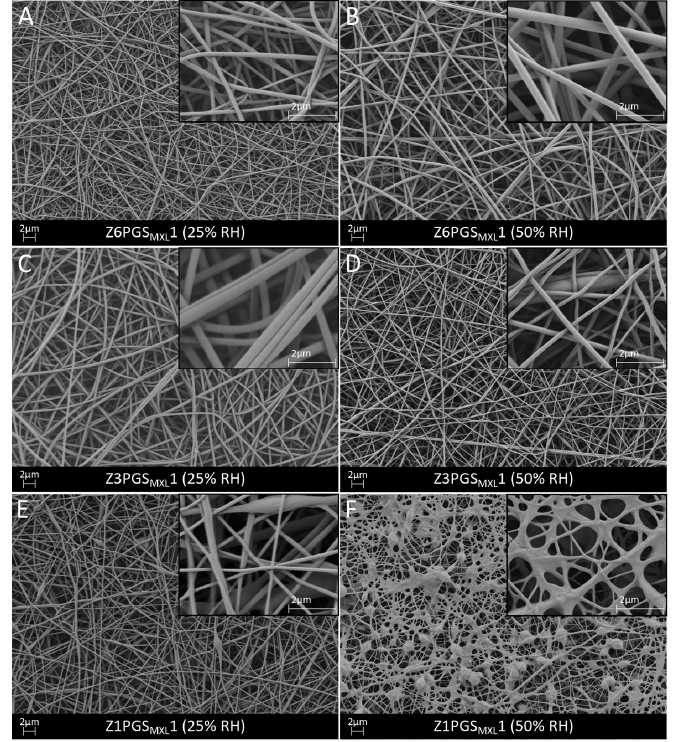
Figure 4. SEM micrographs of zein-PGS fiber mats: Z6PGS MXL 1 ( A , B ), Z3PGS MXL 1 ( C , D ) and Z1PGS MXL 1 ( E , F ) at 25% and 50% relative humidity. The fibers are shown at 5000× magnification and at 20,000× magnification in the inserts.